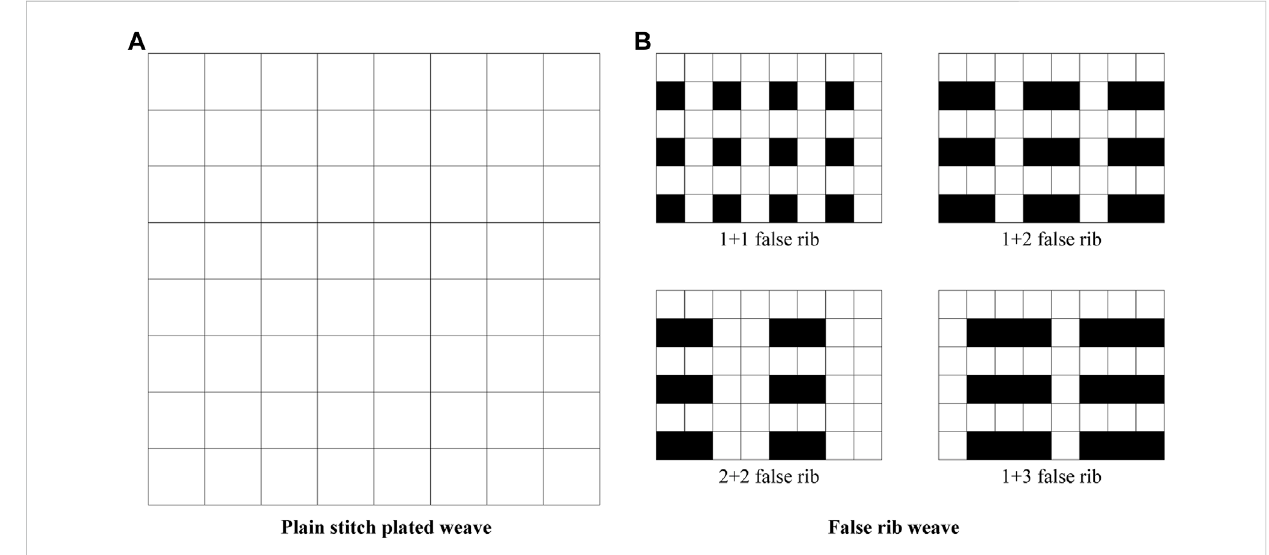
FIGURE 3 Fabric structure. (A) Plain stitch plated weave. (B) False rib weave.